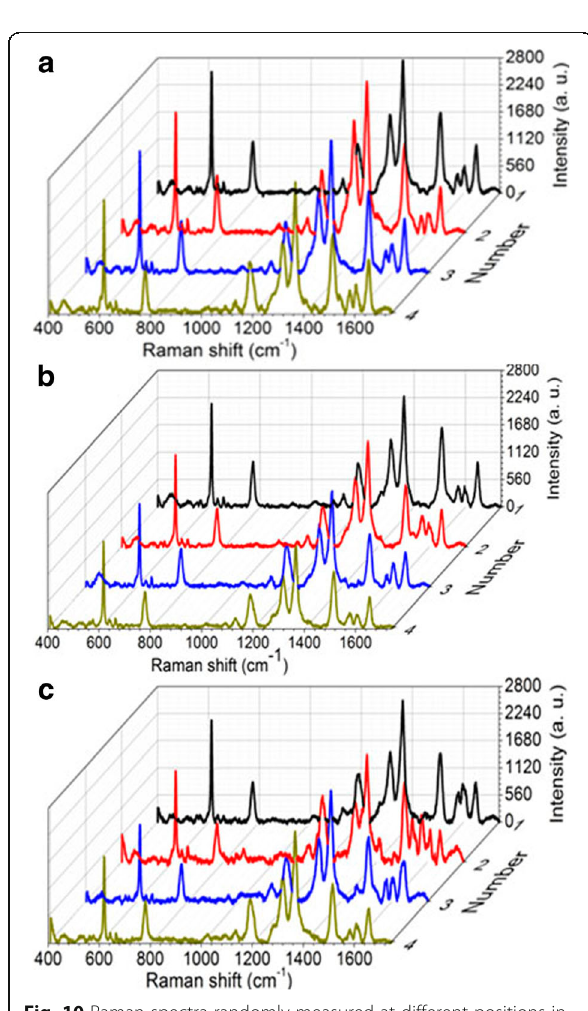
Fig. 10 Raman spectra randomly measured at different positions in the dual-layer porous Au film structures with different layer sputtering time. a 19 s, b 28 s, and c 47 s. Laser power: 0.24